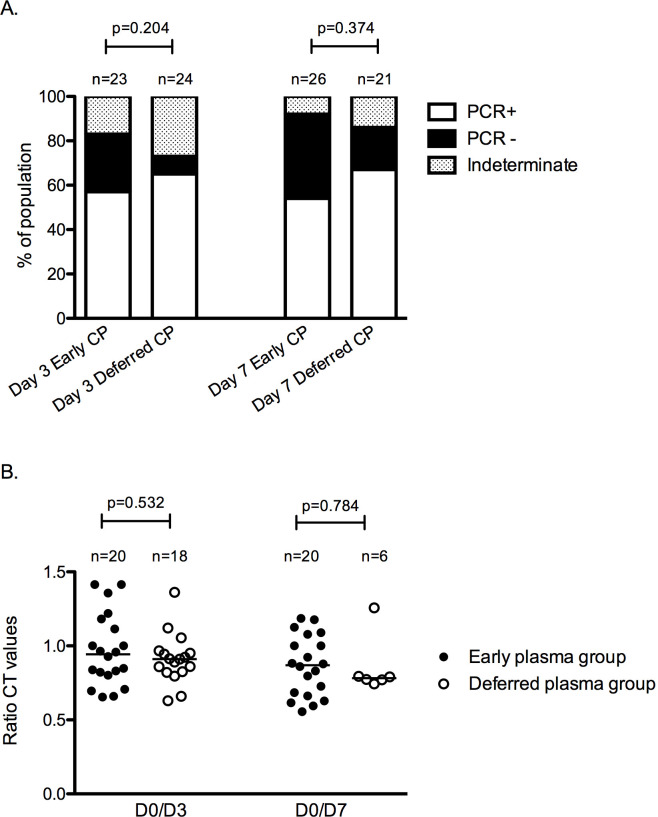
SARS-CoV-2 real-time PCR in nasopharyngeal samples.(A) Each column represents the real-time PCR results obtained in patients from the early plasma group and deferred plasma group. Above the columns, the number of samples is indicated. The proportion of positive PCR is represented in white, negative PCR in black, and an indeterminate result (CT ≥ 35) dotted. (B) Changes in real-time PCR CT for patients from the early plasma group and for the subset of patients from the deferred plasma group that did not receive plasma before day 3 or day 7. Results are expressed as the ratio between CT values from day 0 (D0) to day 3 (D3) and D0 to day 7 (D7). Filled circles represent each patient from the early plasma group, and open circles represent patients from the deferred plasma group. Above the scatter plots, the number of available samples is indicated; lines represent the medians. CP, convalescent plasma; CT, cycle threshold.